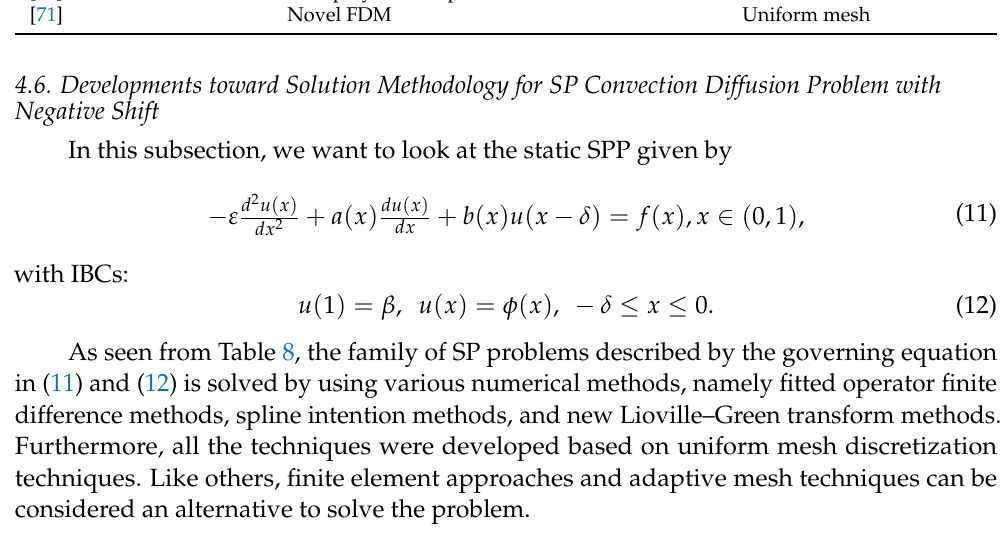
Table 8. Various methods and mesh used to solve Equations (11) and